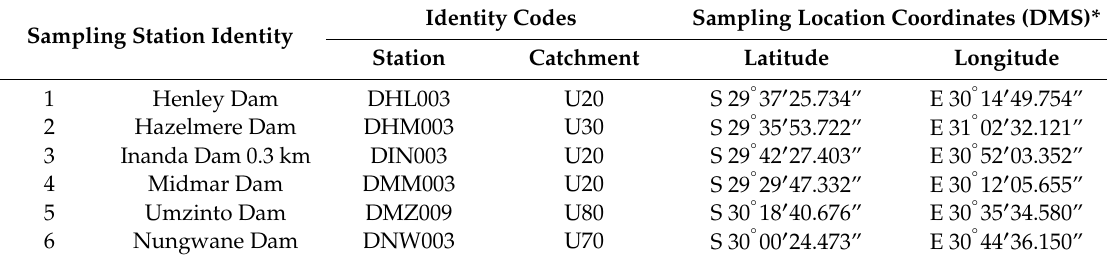
Table 1. Details of sampling stations relevant to the study.